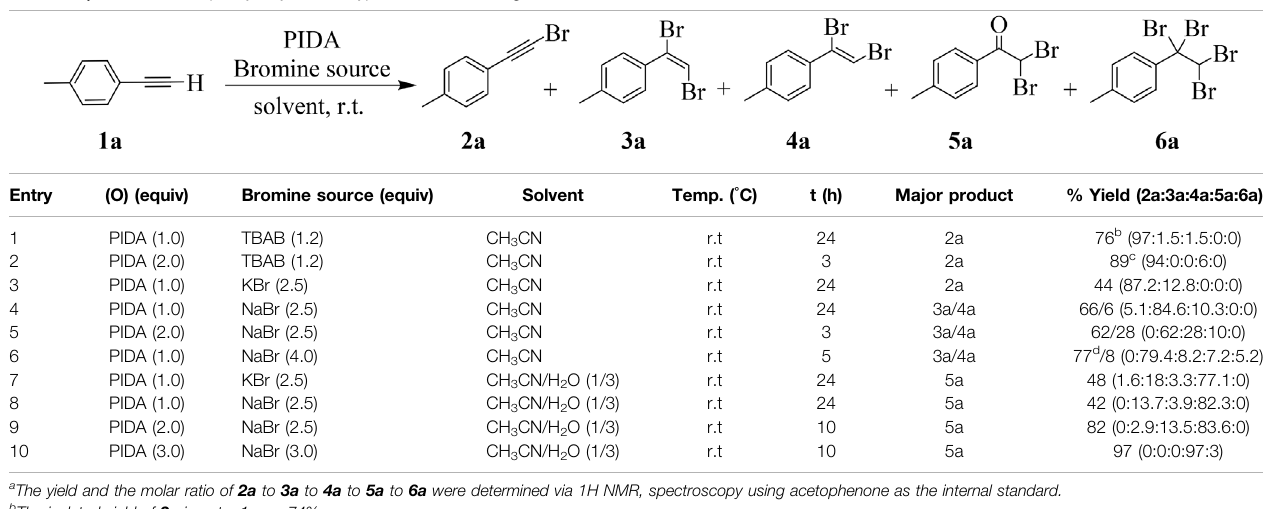
TABLE 1 | Bromination of p -tolylethyne with hypervalent iodine reagent.